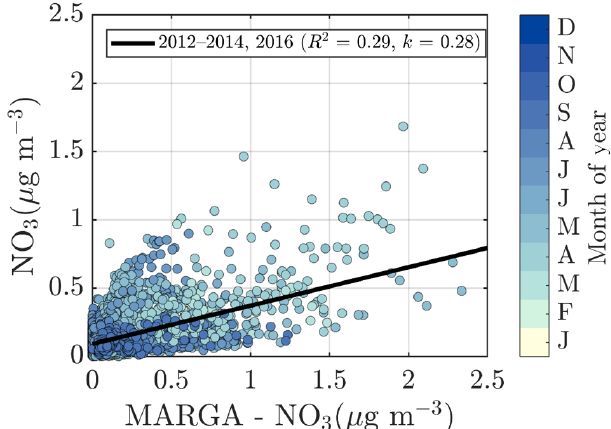
Figure A3. The ACSM nitrate vs. the PM 2 . 5 nitrate detected with MARGA-2S. The color coding represents the month of the year. The black line represents the overall linear